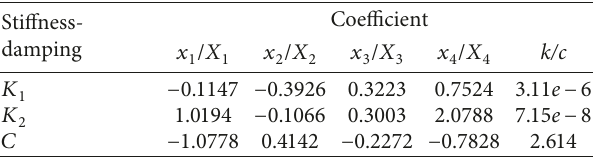
Table 7: The coefficient values after the formula was